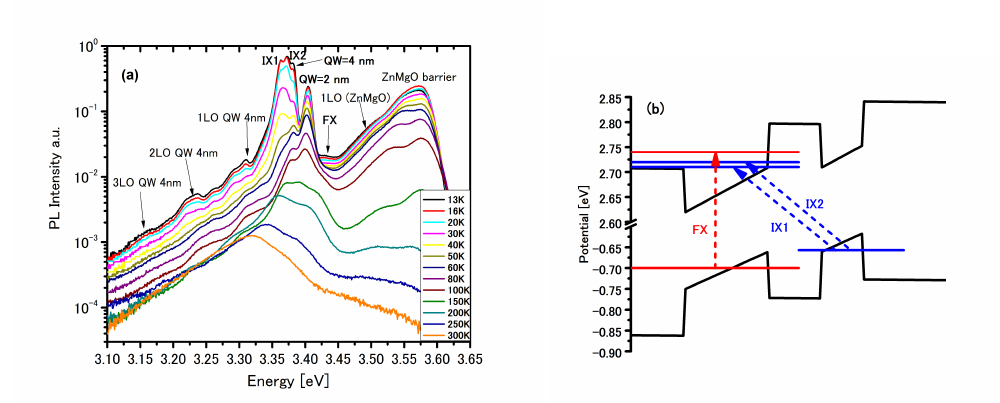
Figure 6. ( a ) The PL spectra at different temperatures for structure #3. ( b ) Schematic diagram for spatially direct (FX—dash red line) and indirect (IX1 and IX2—dash blue lines) excitons in a tilted DQW with narrow ZnMgO barrier. For continence, the confinement potential (black lines) and electron end hole energy levels are in single particle